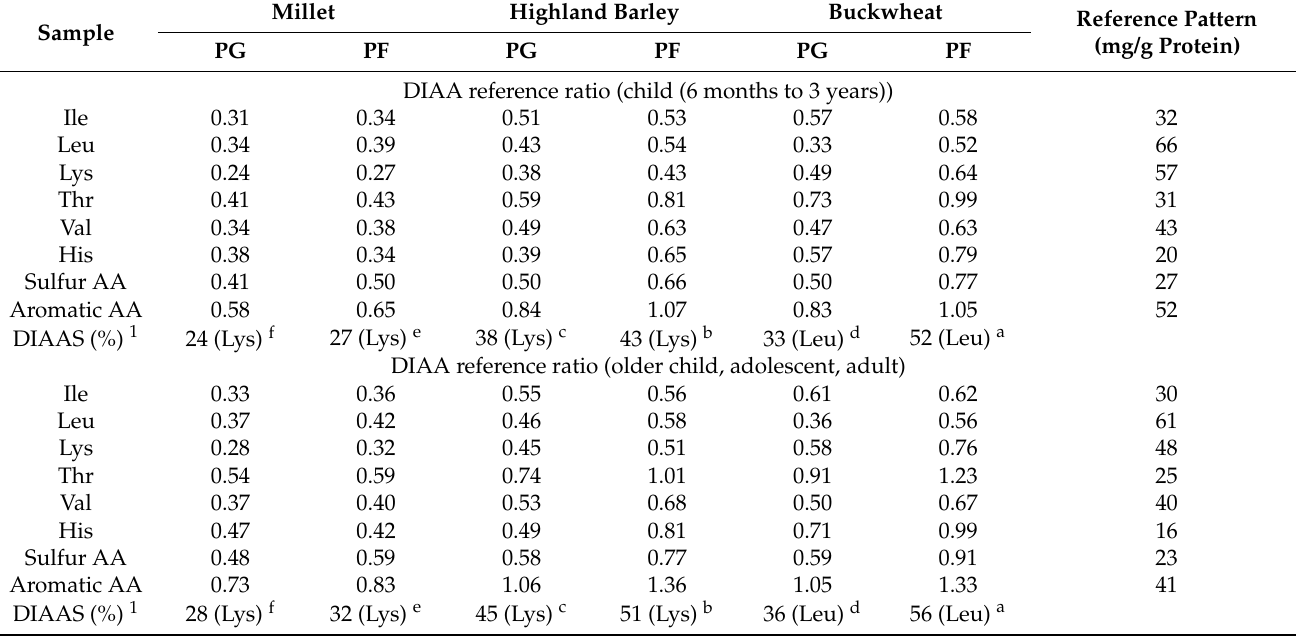
Table 4. Digestible indispensable amino acid (DIAA) reference ratio and DIAAS of cereal-based